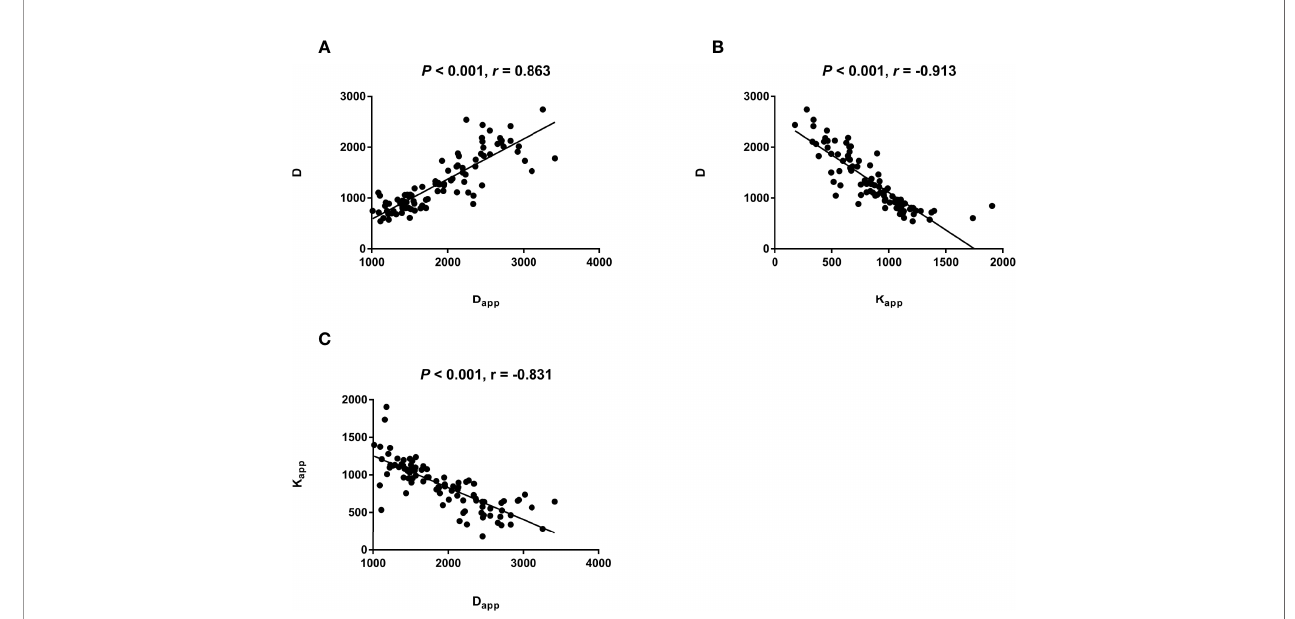
FIGURE 1 | The scatter plot re fl ecting correlation of quanti fi cation parameters between IVIM and DKI.